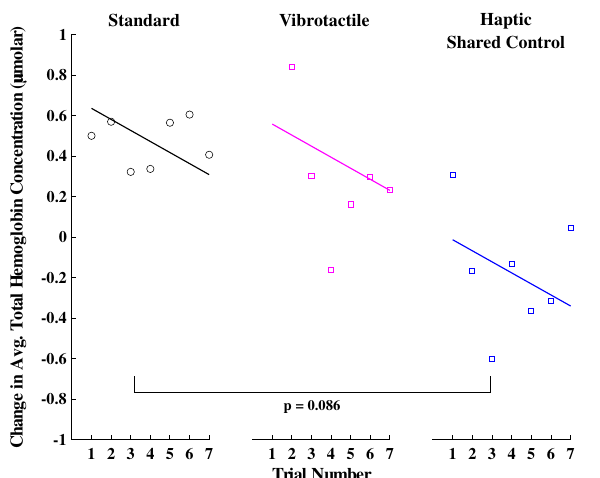
Figure 7. The average total hemoglobin concentration for each trial, where the individual data points represent the average for each trial (for all participants in each group), and the solid lines indicate the model’s prediction. * indicates p < 0.05 , ** indicates p < 0.01 , and *** indicates p < 0.001